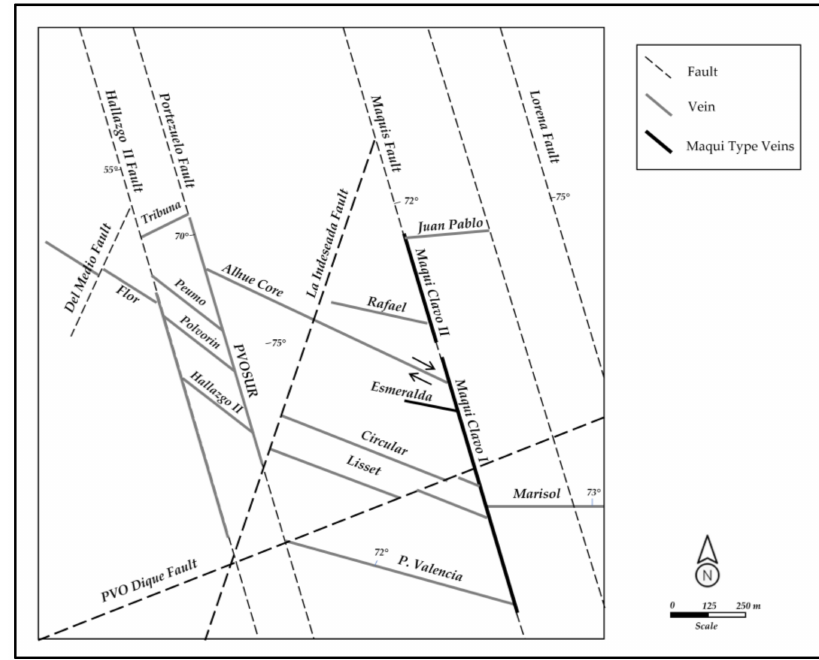
Figure 2. Schematic map of the Alhu é district vein